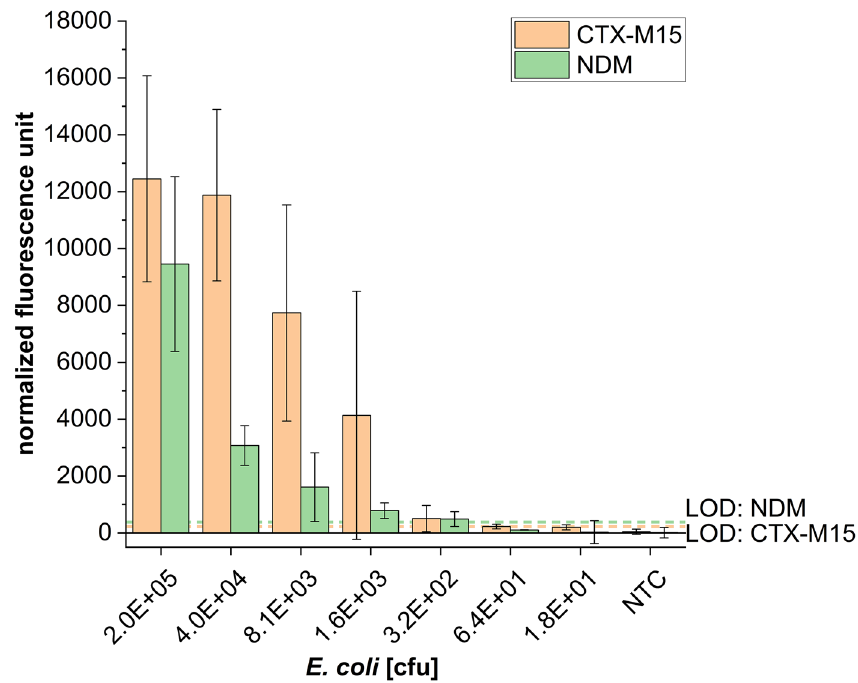
Figure 4. LOD determination for the genes bla CTX-M15 , and bla NDM . 40 min RPA (38 °C) was performed with genomic DNA using bla CTX-M15 and bla NDM in two different E. coli strands. Dilution series of E. coli genomic DNA from 1 ng up to 6.4E−05 ng genomic DNA corresponds to the indicated cell numbers (x-axis). Fluorescence intensity are normalized to the mean signal intensities of the hybridization control in each array. The limit of detection (LOD) was calculated using the sum of the fluorescence signal of the NTC and the two fold standard deviation. Specific probes are CTX-M15_P200 ( bla CTX-M15 ) and NDM_P_new ( bla NDM ) (error bar = standard deviation; n =